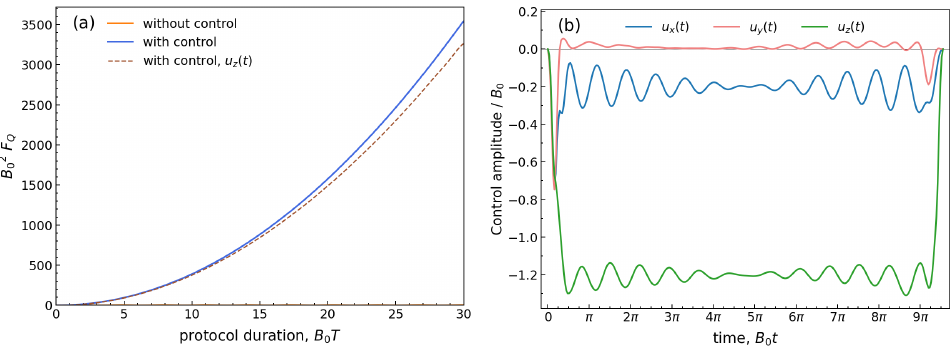
− 2 ) 0 − 1 ), showing a 0